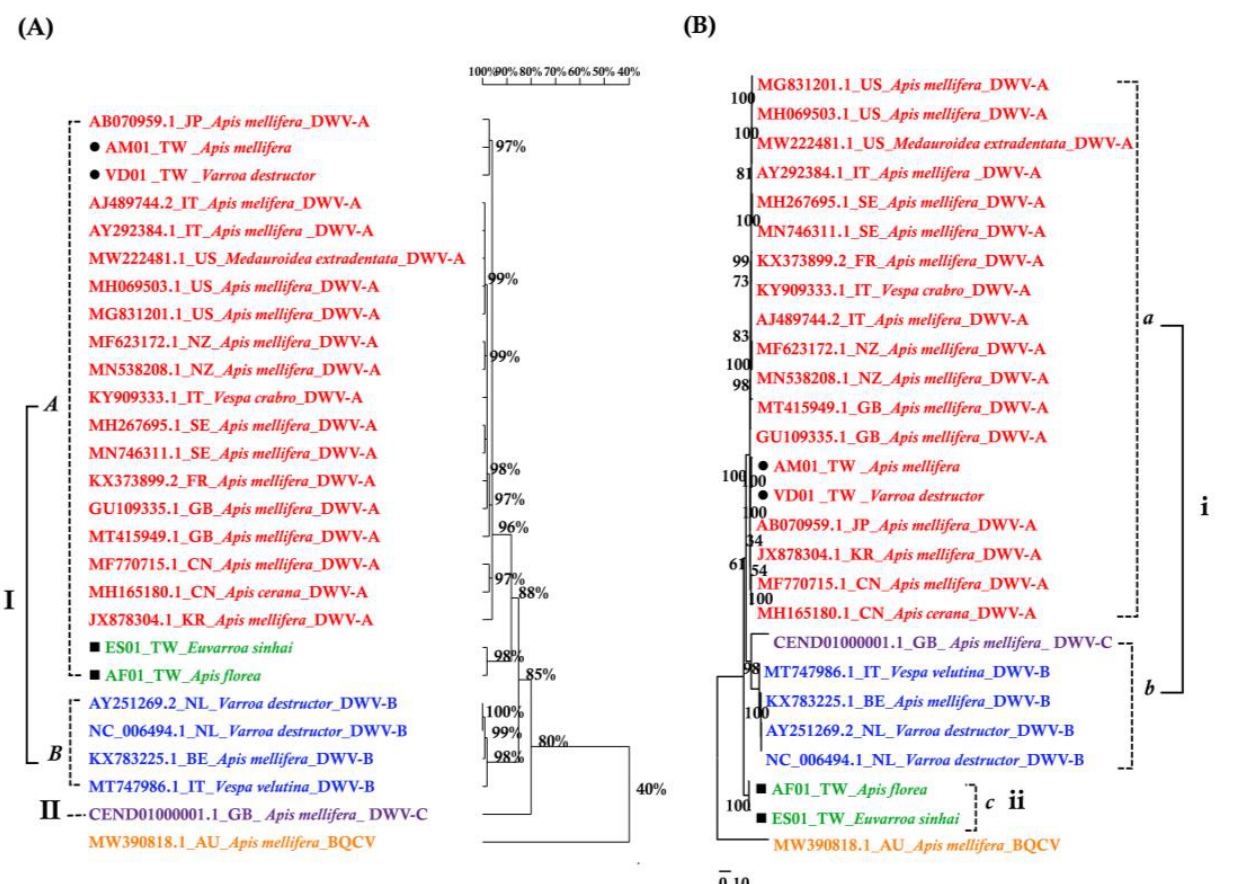
Figure 3. Maximum-likelihood phylogenetic tree (Tamura-Nei model; 1000 replicates) constructed based on the RdRp region sequence of four isolates in this study; the 22 DWV-associated strains and complete genome were from the NCBI database.